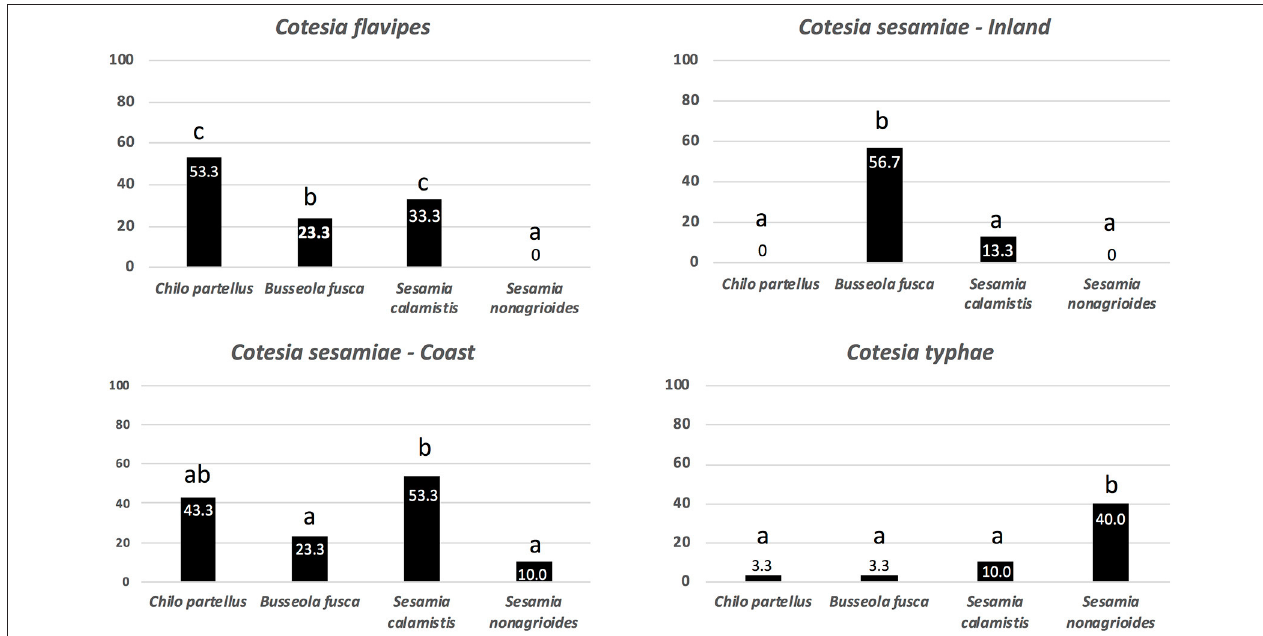
FIGURE 3 | Response of Cotesia flavipes , Cotesia sesamiae -Inland, Cotesia sesamiae -Coast, and Cotesia typhae females to purified α -amylase from different host species. The percentages of females ( n = 30) that exhibited antennation and stinging attempts are given for each bar. After Pearson’s Chi-squared test, bars headed with a different letter are significant at a 5% level according to the Marascuilo procedure (multiple proportions